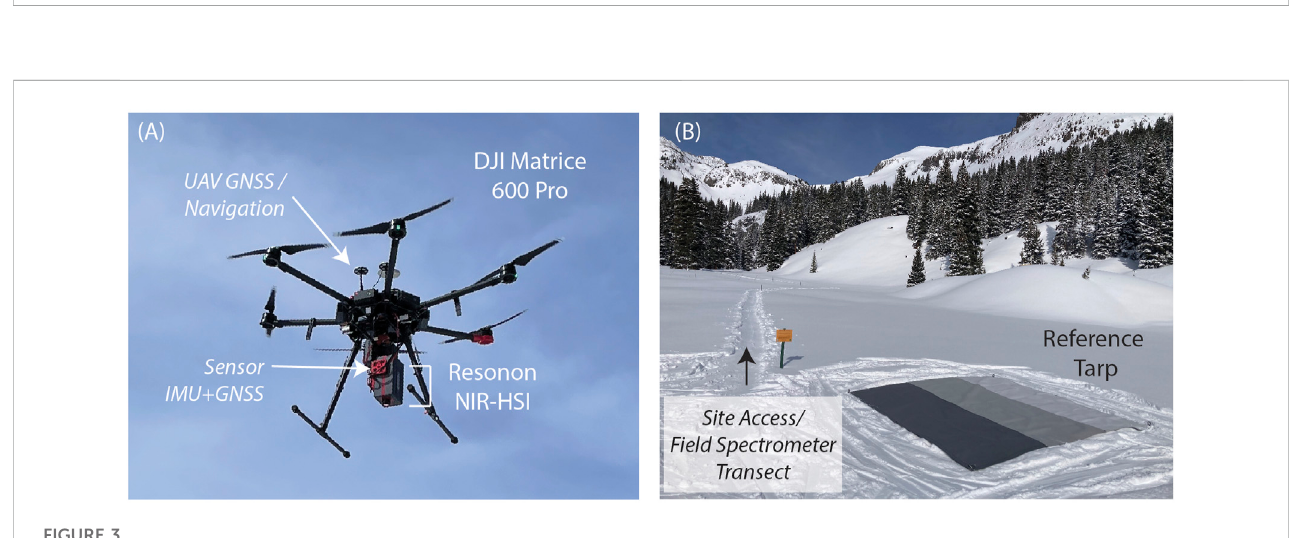
Frontiers in Remote